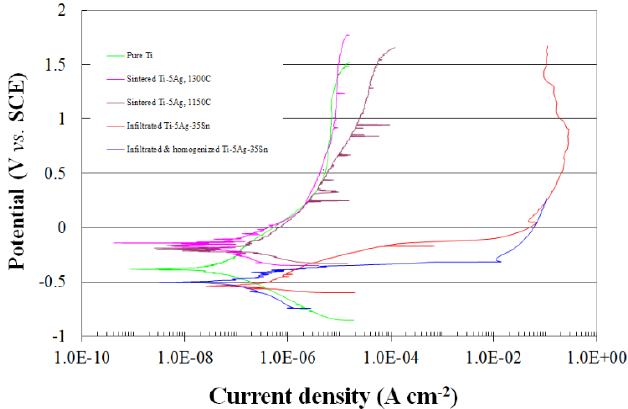
Figure 15. Potentiodynamic polarization curves in saline solution at pH 5.5, T = 37 ◦ C, of pure Ti as well as of Ti–5Ag and Ti–5Ag–35Sn alloys processed by three-dimensional printing [187]. Reprinted with permission from Elsevier.